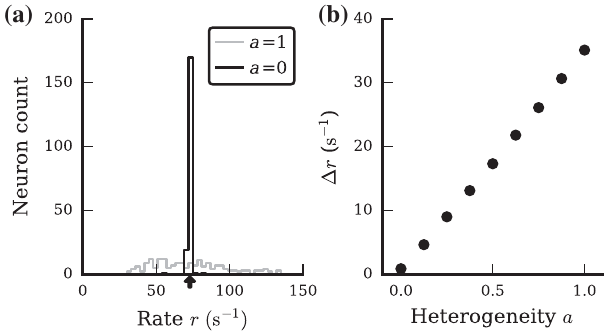
FIG. 4. Calibration of the Spikey chip. (a) Histogram of firing rates r for a population of unconnected neurons with supra- threshold input currents, before (gray line) and after (black line) calibration, each neuron averaged over L ¼ 100 trials. The arrow denotes the target rate ¯ r . (b) Difference Δ r ¼ r and 25th percentile of the histograms in (a), as a function of network heterogeneity a [Eq. (1)]. The mean firing rate over all values of a is ð 73 . 4 (cid:3) 0 . 3 Þ s − 1